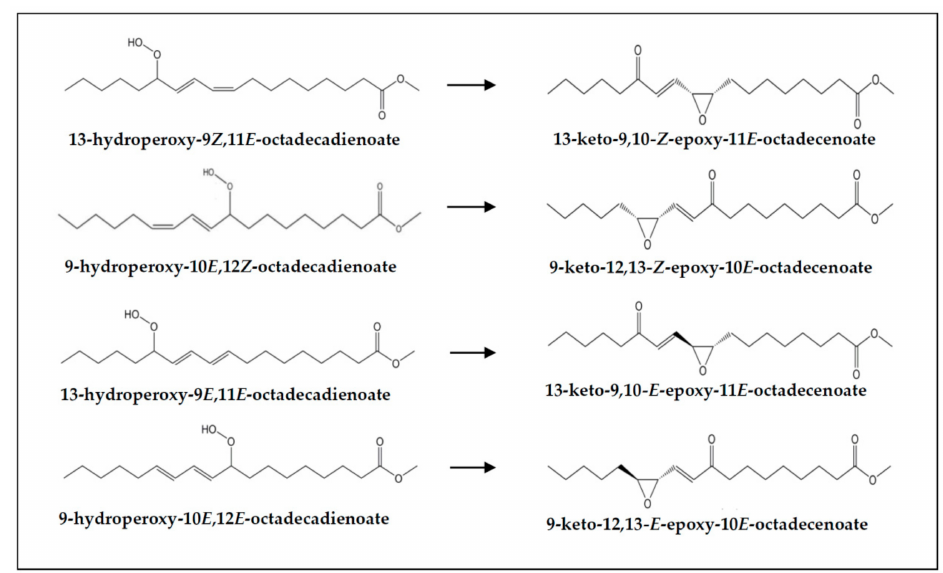
Figure 8. Non-vicinal keto-( Z )-epoxy- and keto-( E )-epoxy-( E )-octadecenoates and their potential monohydroperoxy-(Z, E )- and -( E , E )-octadecadienoate